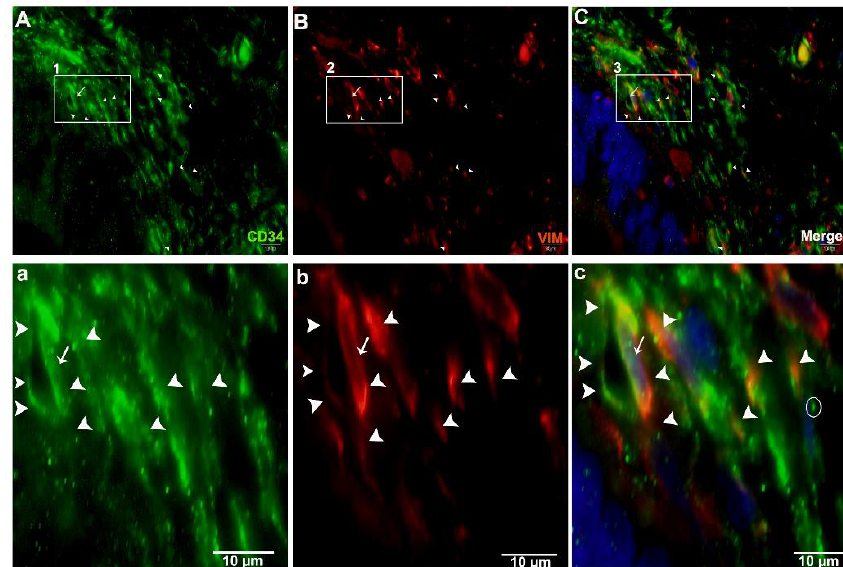
Figure 12. Immunofluorescence-positive telocytes within the connective tissue around the lobular duct. Immunofluorescence CD34 + is shown in green, and Vimentin + in red. Telocytes were scattered around the lobular duct. The square-marked areas 1, 2, and 3 in ( A , B , C ) are enlarged in ( a , b , c ), respectively, with a triangle TC with a long process near the other telopodes, as well as a nucleus (white arrow) and Tps (arrowheads). Scale bar = 10 µ m in ( A – C ); scale bar = 10 µ m in ( a – c ).